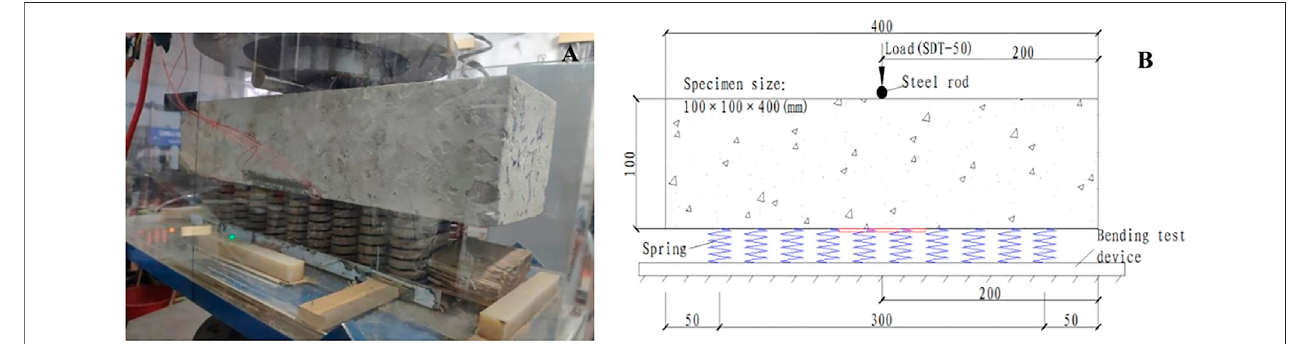
FIGURE 4 | Test without base cavity. (A) test devices; (B) Loading position and support.